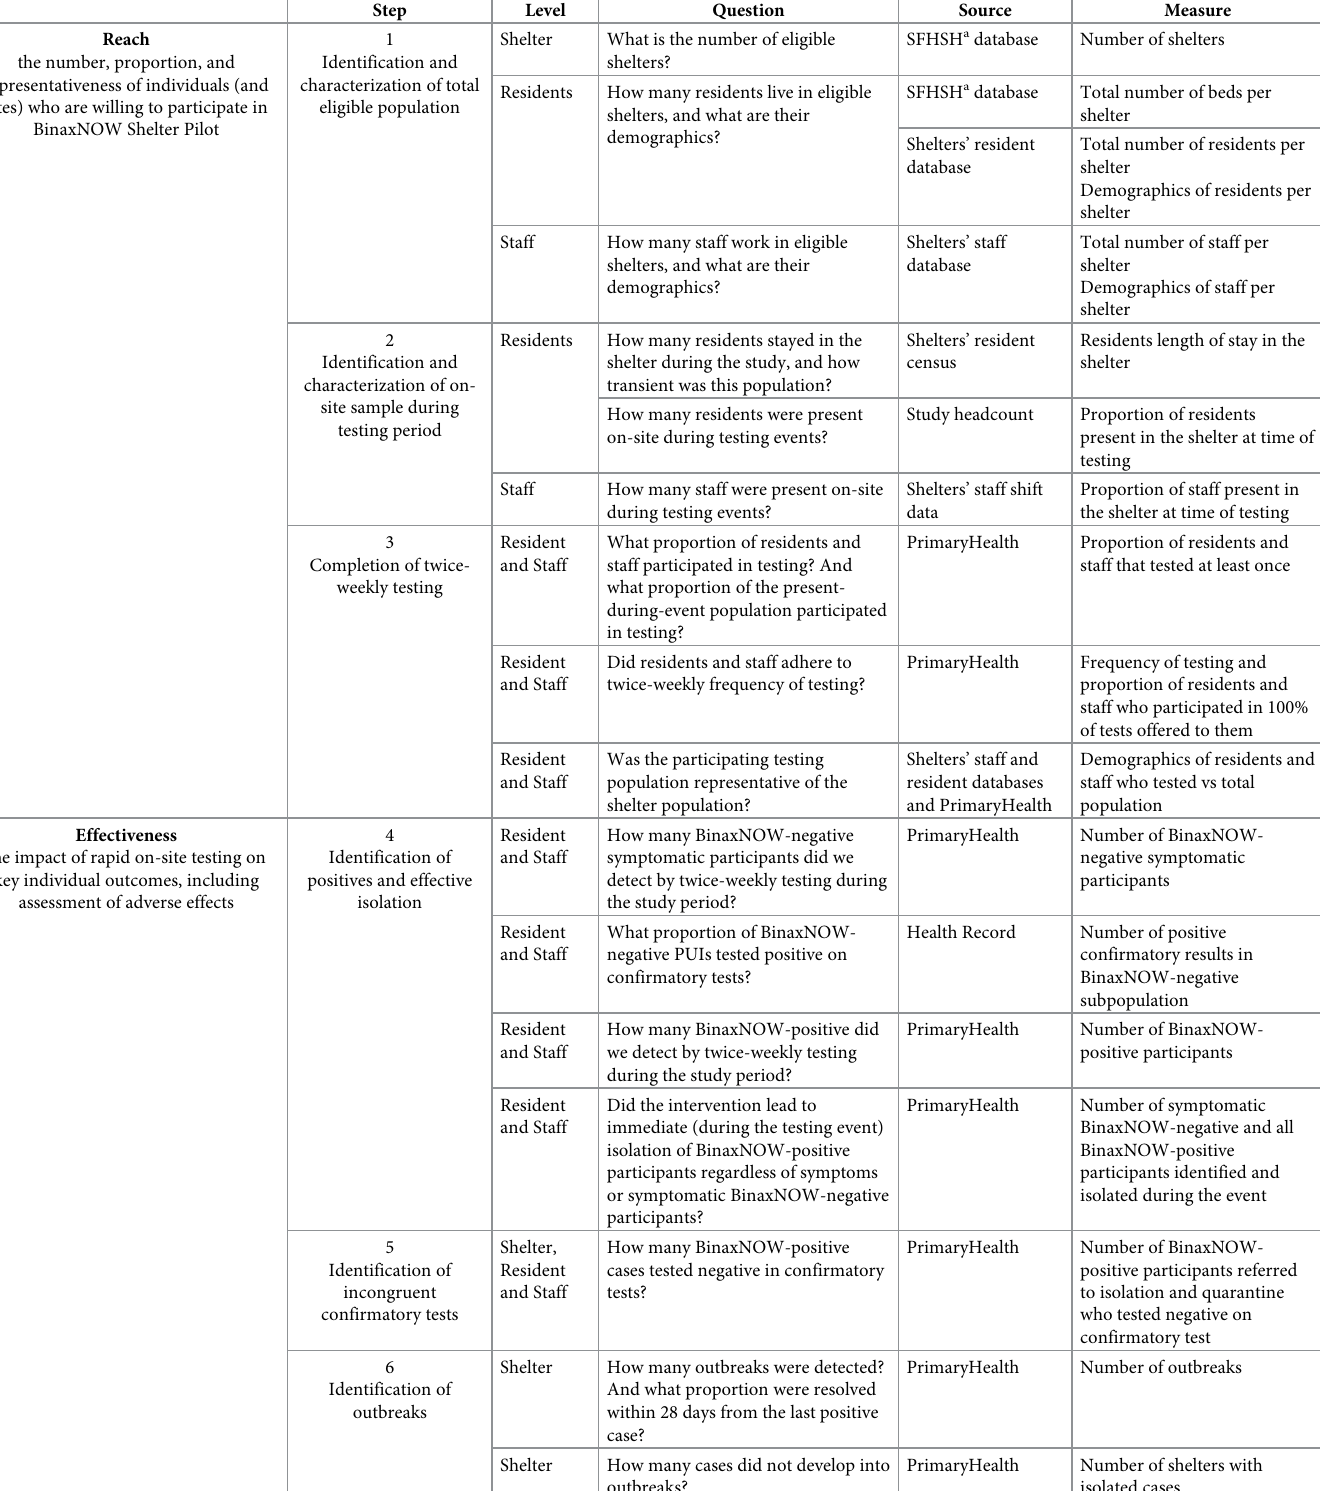
Table 2. RE-AIM framework to evaluate the implementation of rapid SARS-CoV2 antigen testing in homeless shelters, San Francisco, 2021. Step Level Question Reach the number, proportion,